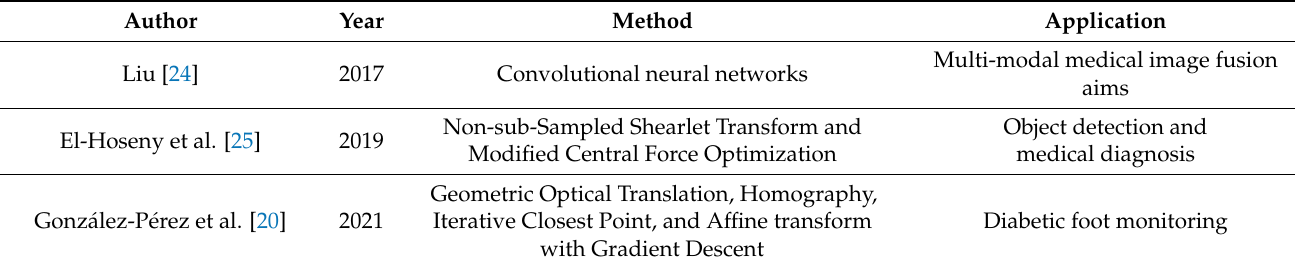
Table 2. Overview of recent studies regarding the registration between visible and thermal images.